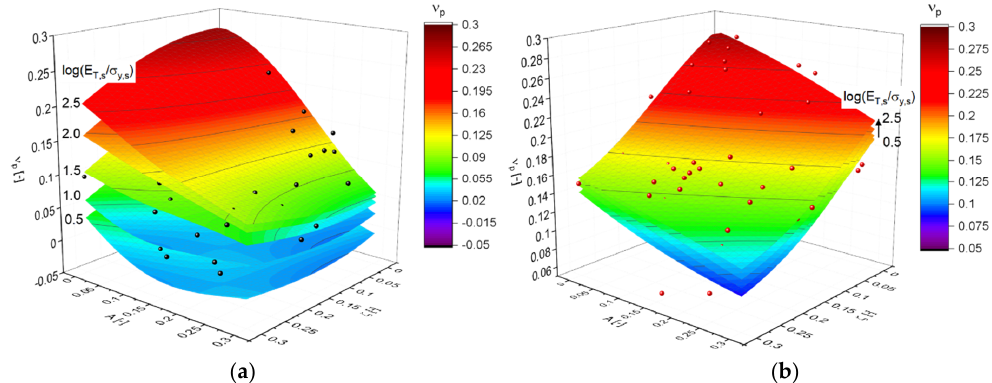
Figure 12. Visualization of the plastic Poisson’s ratio ν p in Equation (13) for ( a ) G 21 : ϕ = 0.12 and ( b ) G 33 : ϕ =